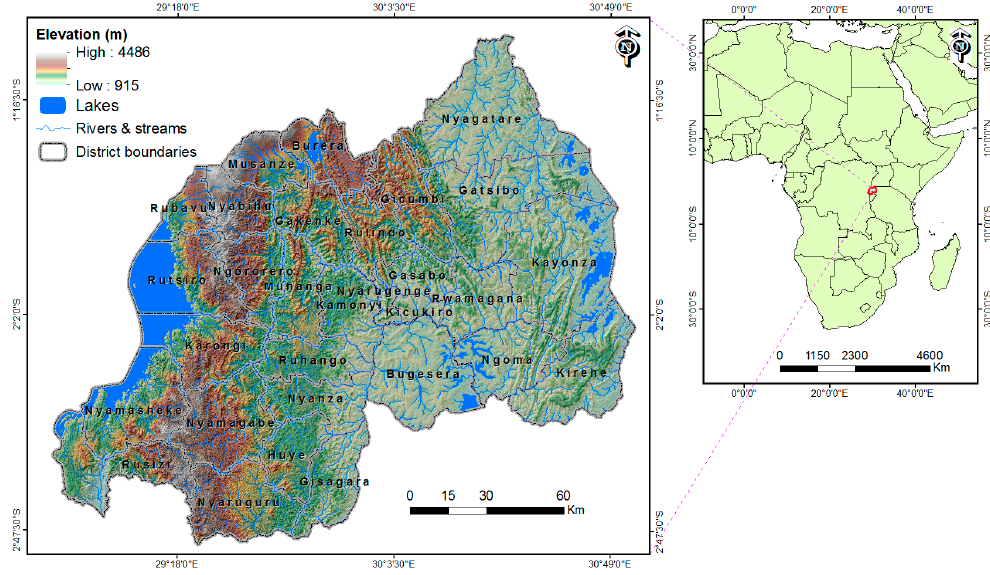
Figure 1. Map of elevation, lakes, rivers, streams and district administrative boundaries for Rwanda.